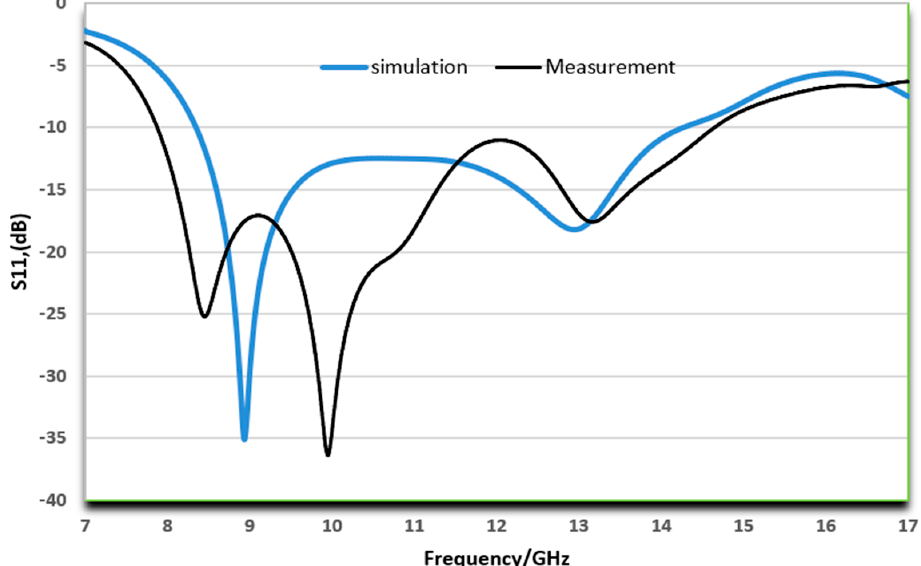
Figure 3. Return loss (S 11 ) vs. frequency plot of the proposed MPA.